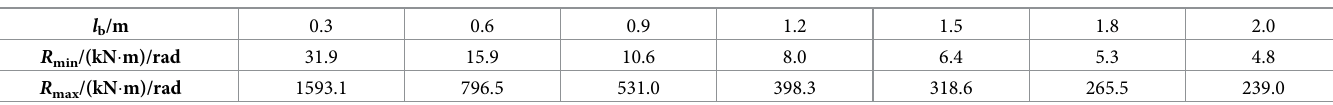
Table 4. Regional boundary of initial bending stiffness of the semi-rigid joint with different transverse and longitudinal distances in model of